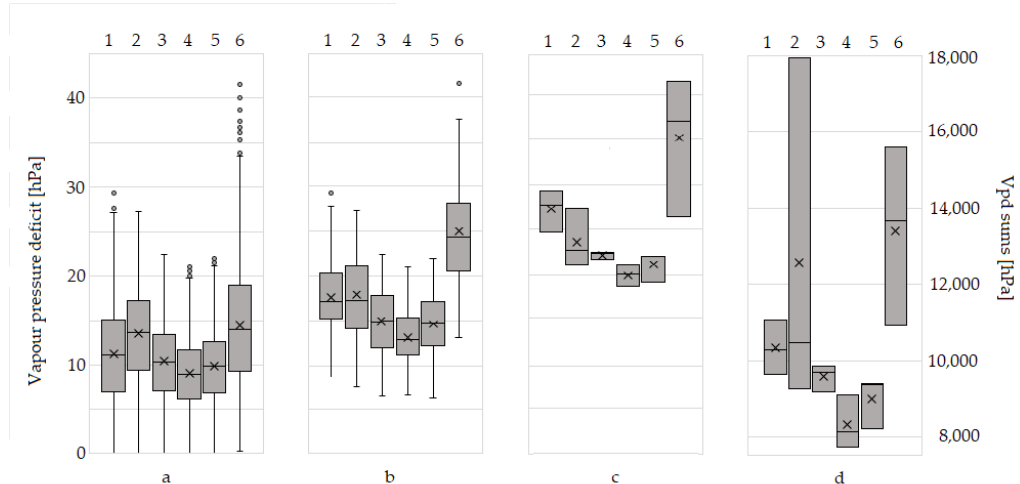
Figure A3. Boxplots with mean (x), median (horizontal line), 25 and 75 percentiles, and minima and maxima of vpd in the study period at the six measuring points, given for the daytime period on cloudless days ( a ), the recorded daily maxima in cloudless periods ( b ), the recorded absolute maxima ( c ), and the summed vpd values for the daytime period on cloudless days ( d ). The six measuring points are 1 = Oa, 2 = Oa/Be(lo), 3 = Oa/Be(up), 4 = Be, 5 = Be(N), and 6 = Ga.